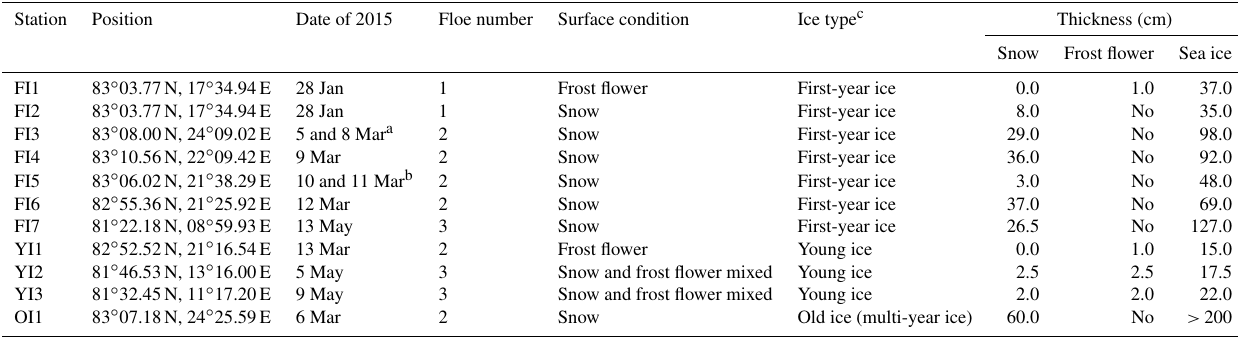
Figure 1. Location map of the sampling area north of Svalbard during N-ICE2015. Image of the sea ice concentrations (a) and station map (b) were derived from Special Sensor Microwave Imager (SSM/I) satellite data for mean of February 2015 and from Sentinel-1 (Synthetic Aperture Radar Sensor) satellite data, respectively. Table 1. Station, date for CO 2 flux measurement, position, floe number, surface condition, ice type and thickness of snow, frost flowers, and sea